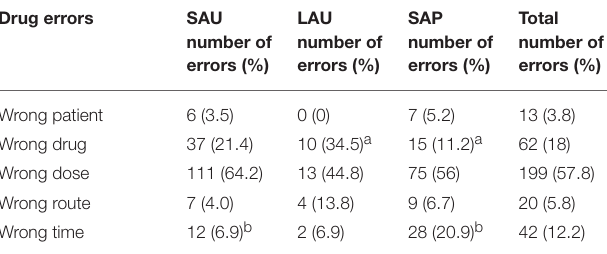
TABLE 6 | Distribution by type of drug error and hospital (see Figure 1 for hospital abbreviations). Drug errors